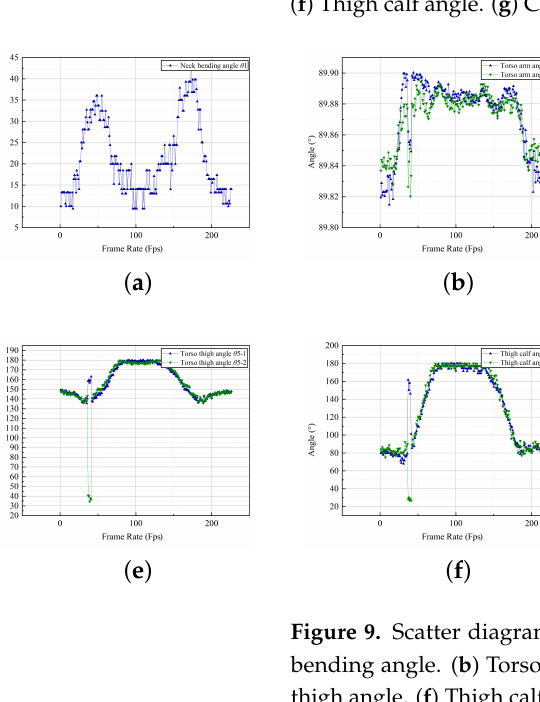
Figure 8. Scatter diagram of the joint angle of the sofa-using behavior. ( a ) Neck bending angle. ( b ) Torso arm angle. ( c ) Elbow bending angle. ( d ) Torso bending angle. ( e ) Torso thigh angle. ( f ) Thigh calf angle. ( g ) Calf-ground angle. ( h ) Total angle collection.